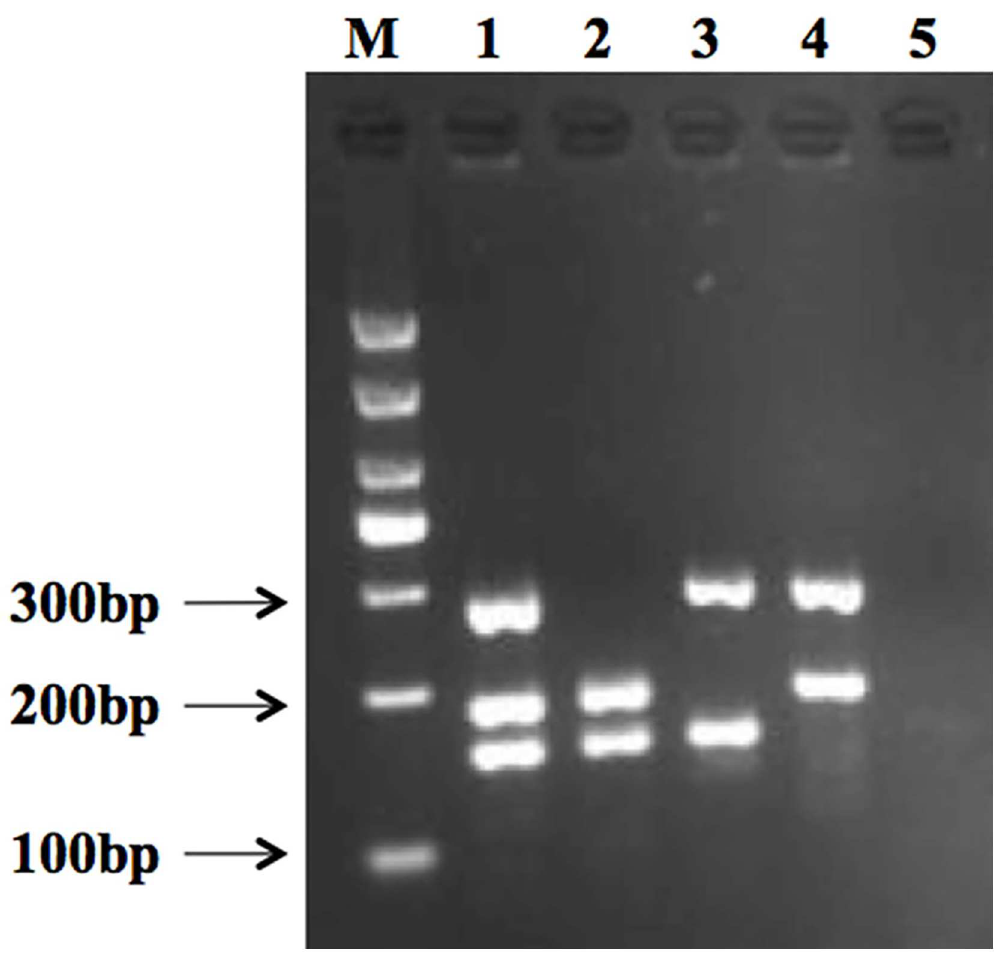
Fig 2. Internal verification and specificity of primers for L . monocytogenes , E . coli O157:H7, and S . aureus . Lane M: 1000 bp DNA marker. Lane 1 shows PCR ampliconsspecific to L . monocytogenes (285 bp), E . coli O157: H7 (193 bp), and S . aureus (159 bp). Lane 2 shows PCR ampliconsspecific to S . aureus (159 bp) and E . coli O157: H7 (193 bp). Lane 3 shows PCR ampliconsspecific to L . monocytogenes (285 bp) and S . aureus (159 bp). Lane4 shows PCR ampliconsspecific to E . coli O157:H7 (193 bp) and L . monocytogenes (285 bp). Lane 5 shows results for the